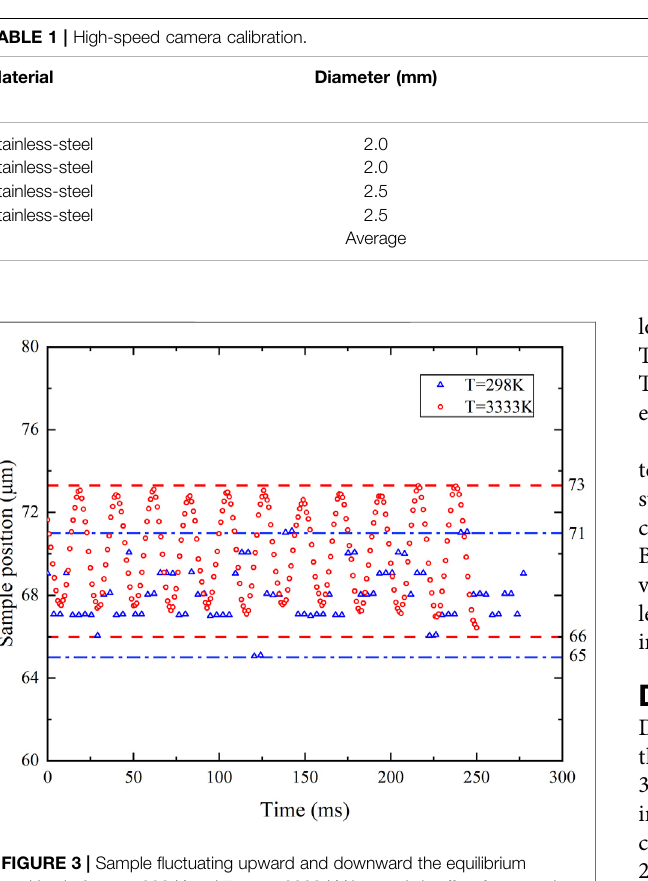
FIGURE 3 | Sample fl uctuating upward and downward the equilibrium position in 6 μ m at 298 K and 7 μ m at 3333 K (the y-axis is offset for zoom-in